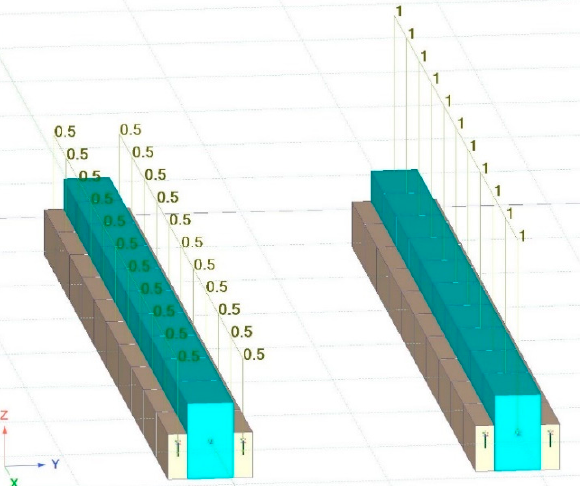
Figure 6. Visualization of design schemes, taking into account the assigned cross sections. The central rib is blue. Two side shelves are beige. As can be seen from the visualization, the sections do not intersect. The lower faces of the rib and flanges coincide.